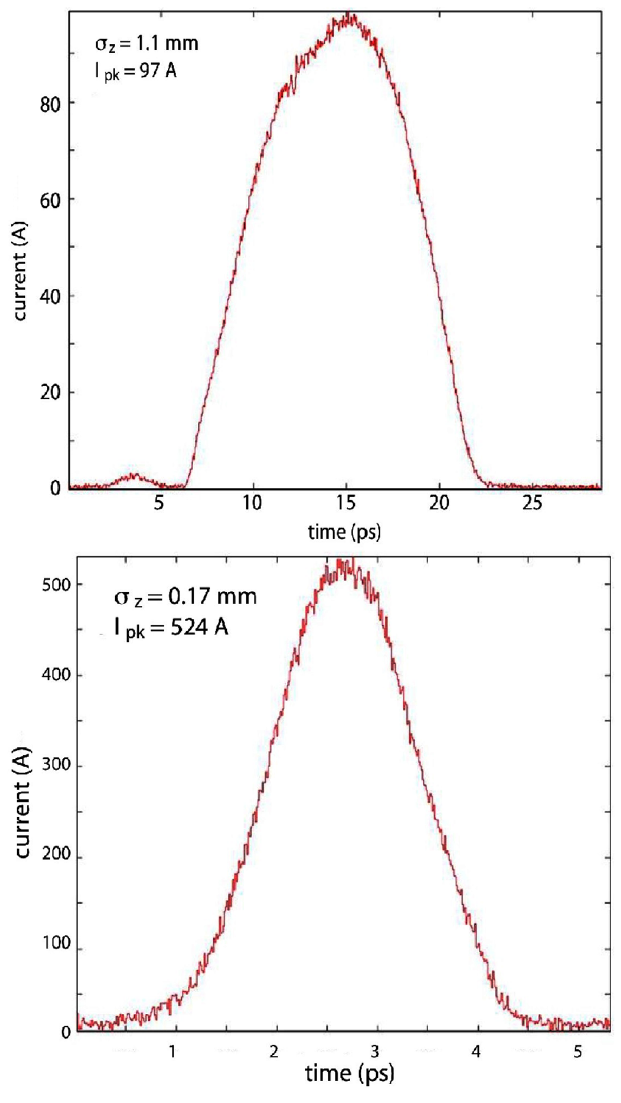
FIG. 38. (Color) Bunch length distribution measured using both rf deflectors. The first measurement is at 135 MeV (top: (cid:3) (cid:3) 97 A ) and the second is at 14 GeV (bottom: 1 : 1 mm , I pk (cid:3) 0 : 17 mm , I (cid:3) 520 A ), representing the bunch length (cid:3) z pk before and after BC1 compression at 1 nC.